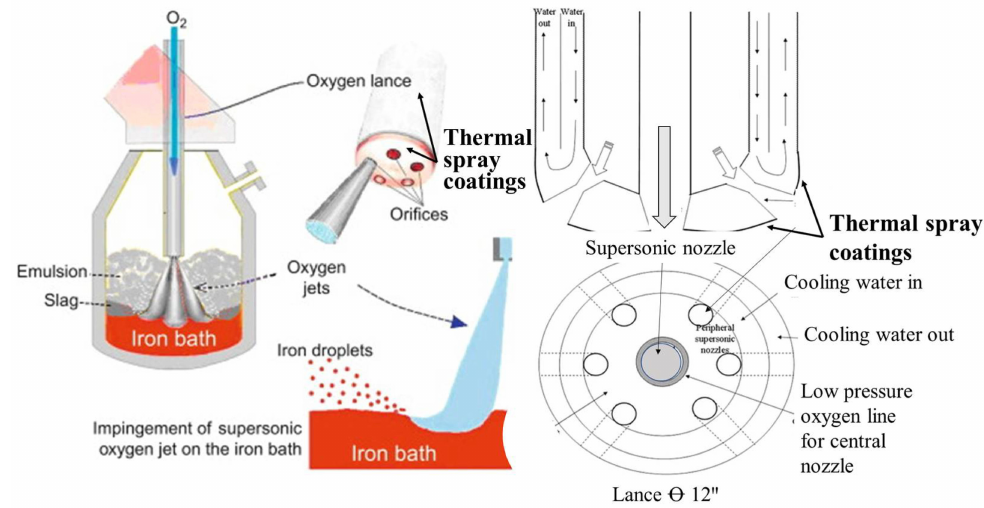
Figure 6. ( left ) Schematic representation of gas/fuel purging system in the furnace and enlarged view of the blowing end of lances that are exposed to the high temperature environment of a blast furnace. Reprinted with permission from [27]. 2014, Elsevier. ( right ) Drawing of the seven-hole lance design with a central subsonic nozzle, adapted from [28]. 2007, Springer Nature.